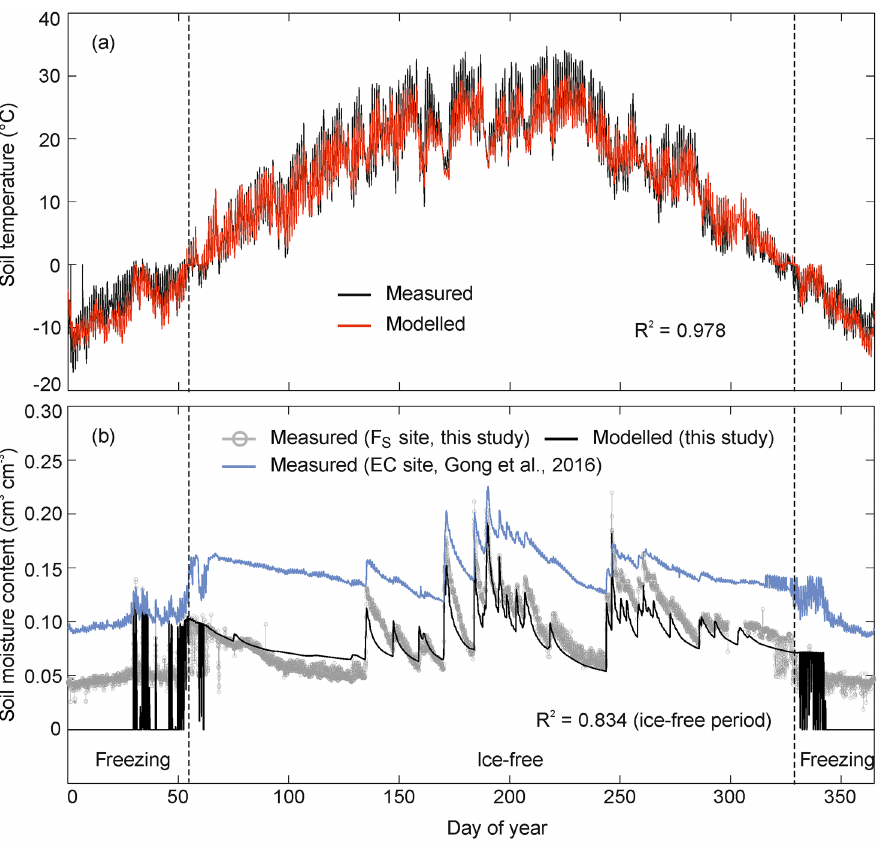
Figure 4. Measured and modelled soil temperature (a) and soil moisture content (b) at 10cm depth for the F S site and as compared to the EC site in the year 2013 by Gong et al. (2016).